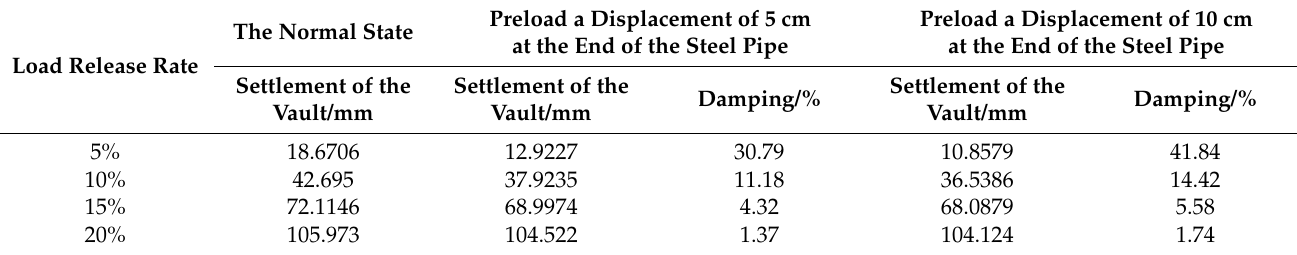
Table 5. The influence of two active bearing FSPs of 89 × 8 mm on settlement of the arch